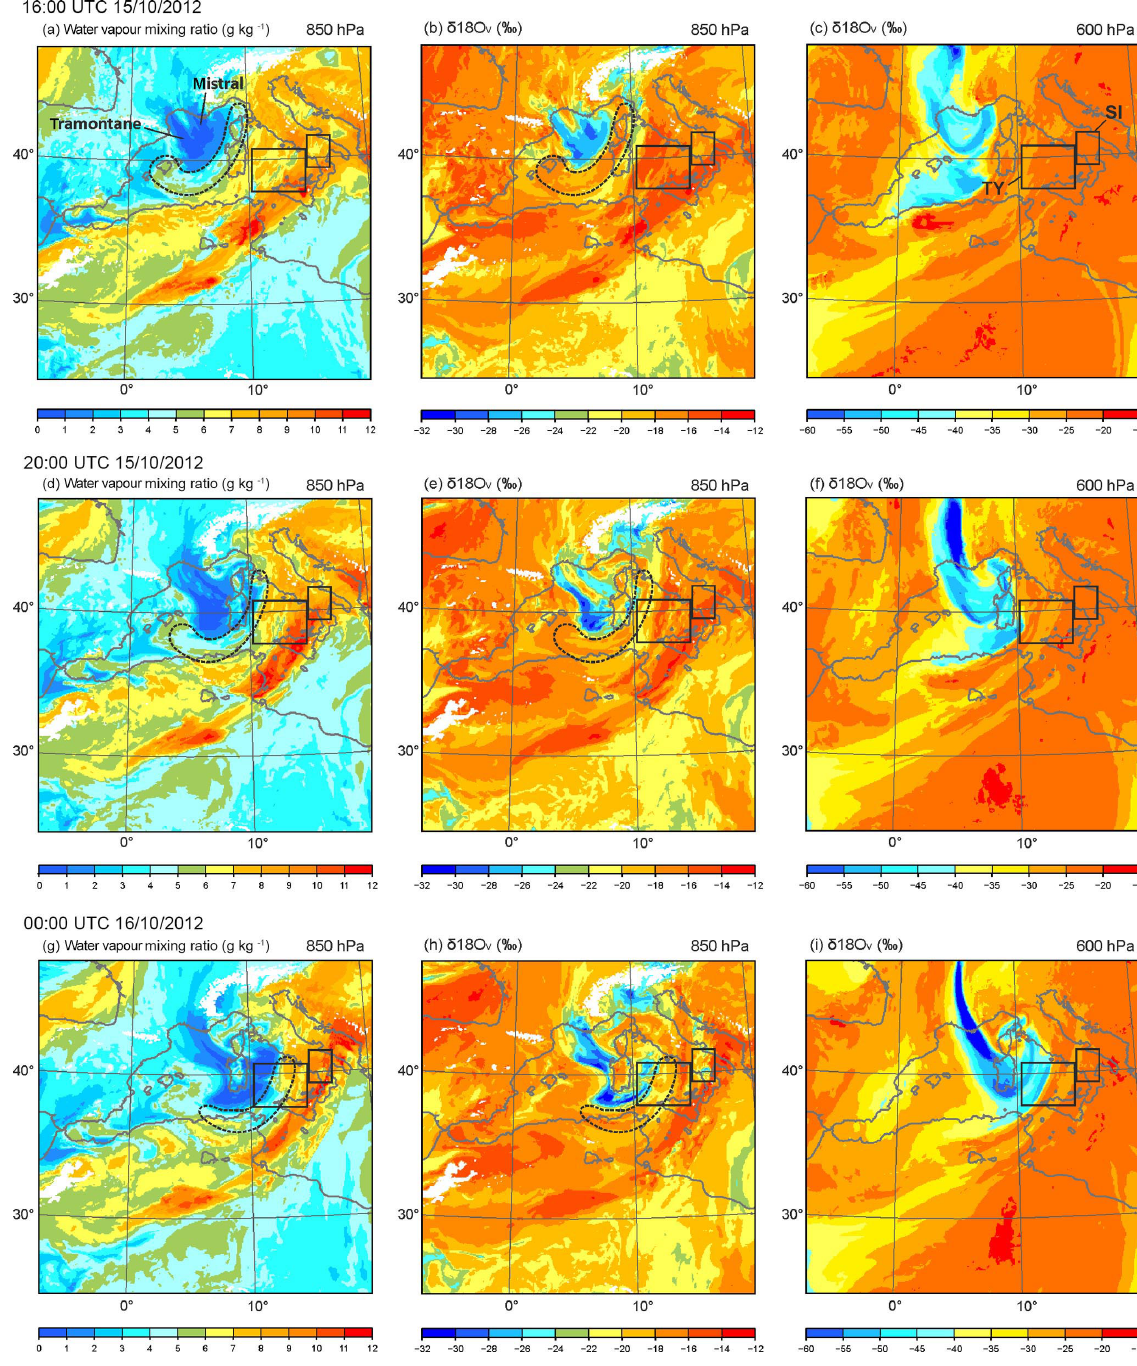
Figure 4. Horizontal distributions of water vapour mixing ratio at 850hPa (a, d, g) , δ 18 O v at 850hPa (b, e, h) , and δ 18 O v at 600hPa (c, f, i) at 16:00UTC (a–c) and 20:00UTC (d–f) on 15 October 2012 and at 00:00UTC on 16 October 2012 (g, h, i) .